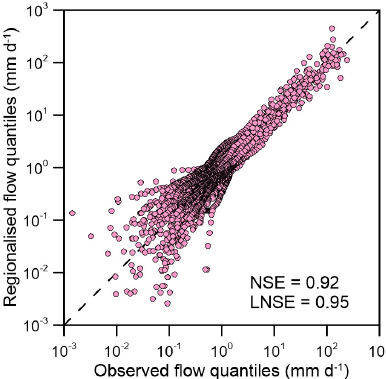
Figure 4. 1:1 scatter plot between the empirical flow quantiles and the flow quantiles predicted by the top-kriging FDC regionalisation method.